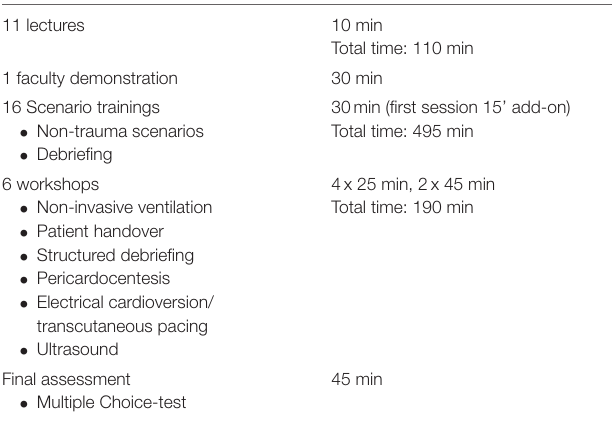
TABLE 4 | Pedagogical elements of the “Advanced Critical illness Life Support”